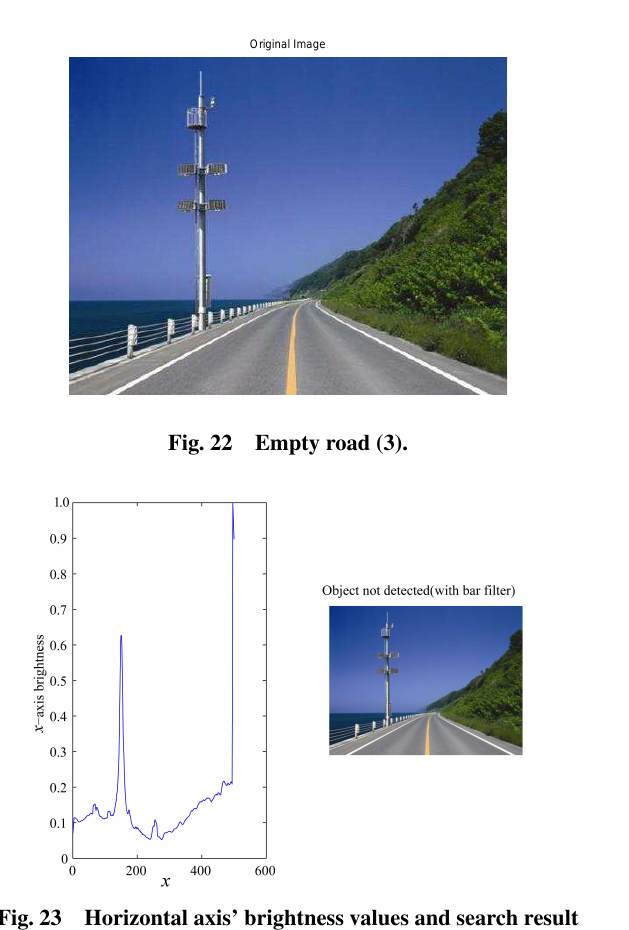
Fig. 21 Horizontal axis’ brightness values and search result (with grate filter) according to Fig. 19.